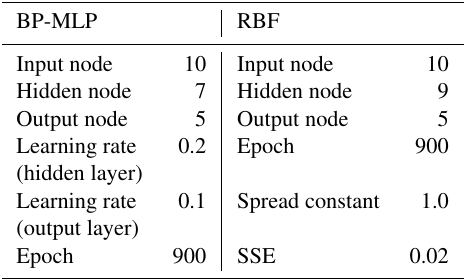
Table 1. Artificial neural network architecture and parameters.